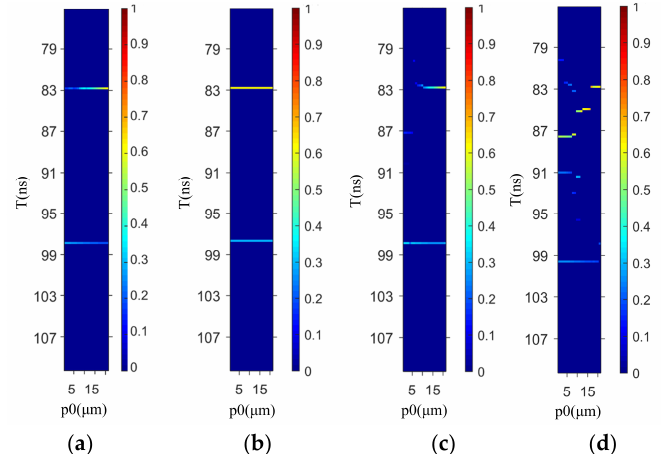
Figure 11. Sparse characterization coefficient diagram of typical defect models: ( a ) defect-free, ( b ) ball missing, ( c ) void, ( d ) crack.